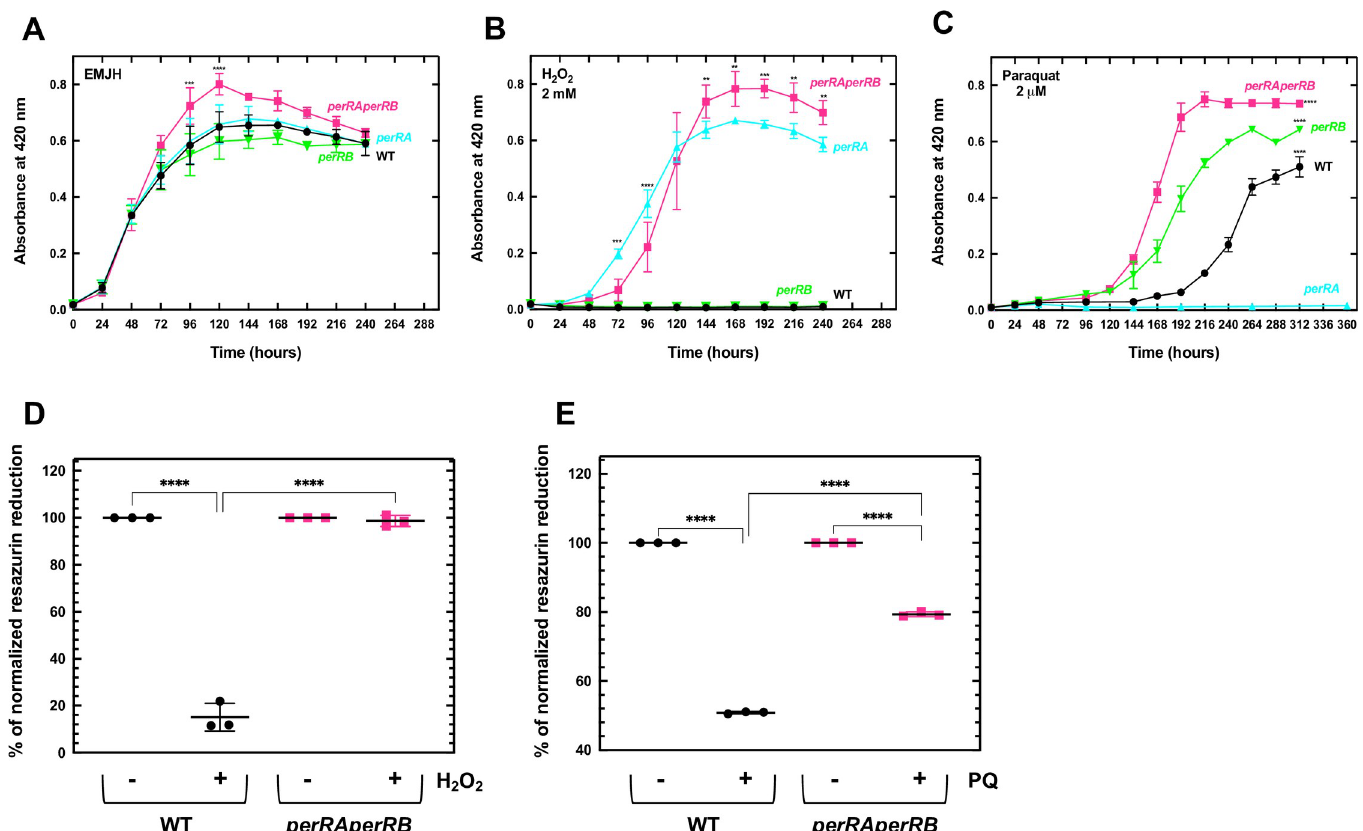
Fig 6. Effect of concomitant inactivation of perRA and perRB on Leptospira growth in the presence of ROS. L . interrogans WT (black circles), the single perRA mutant (cyan triangles), the single perRB mutants (green inverted triangles) or the double perRAperRB mutant (pink squares) were cultivated in EMJH medium in the absence (A), or in the presence of 2 mM H 2 O 2 (B) or 2 μ M paraquat (C). Growth was assessed by measure of absorbance at 420 nm and the data are means and standard errors of three independent biological replicates. In panel A, statistical significance between the perRAperRB mutant and the other strains was determined by Two-way Anova test ( ��� , p-value < 0.0008; ���� , p-value < 0.0001). In panel B, statistical significance between the perRA and the perRAperRB mutants was determined by two-way Anova test ( �� , p-value < 0.008; ��� , p-value < 0.0005; ���� , p-value < 0.0001). In panel C, two-way Anova test indicated that differences between WT, perRB mutant, and perRAperRB mutant were significant from 144 h ( ���� , p-value < 0.0001). Quantitative survival tests were performed by incubating exponentially growing WT (black circles) and double perRAperRB mutant (pink squares) with 5 mM H 2 O 2 for 30 min (D) or 100 μ M paraquat for 60 min (E). Resazurin reduction was determined as described in the Materials and Methods section. Data are means and standard errors of three independent biological replicates. Statistical significance was determined by a One-way Anova test ( ���� , p-value <